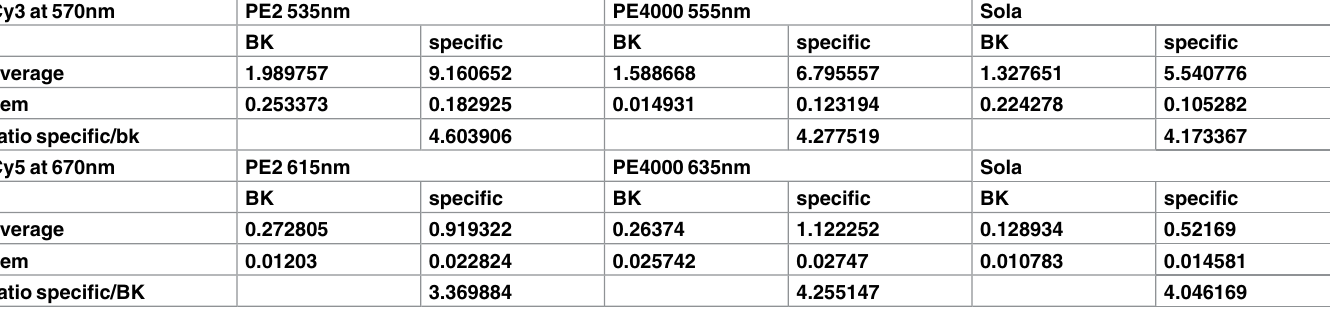
Table 6. Autofluorescenceand specificfluorescence at peak of emission for Cy3 & Cy5 excitedby whitelightLED (SOLA),PE2 (535nm& 615nm) or PE4000 (555 & 635nm).